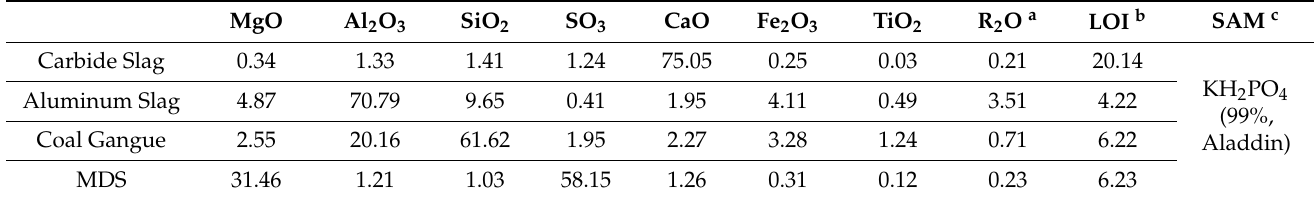
Table 2. Chemical composition of the raw materials